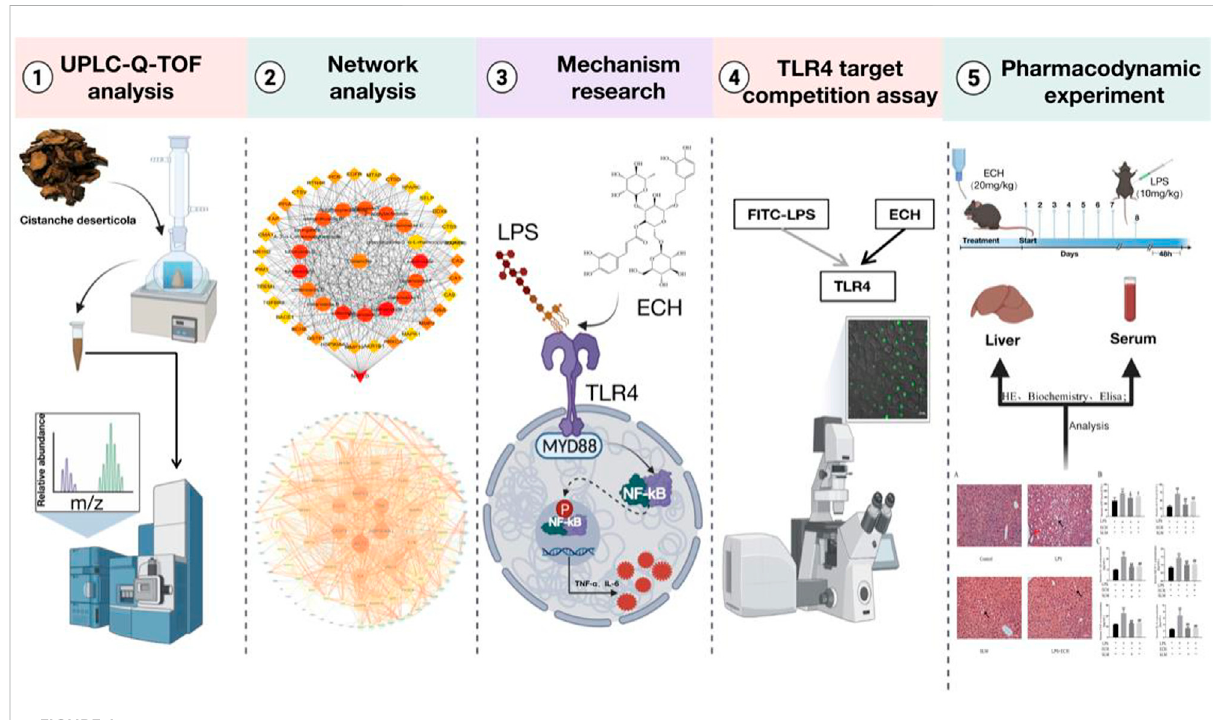
FIGURE 1 Comprehensive strategy